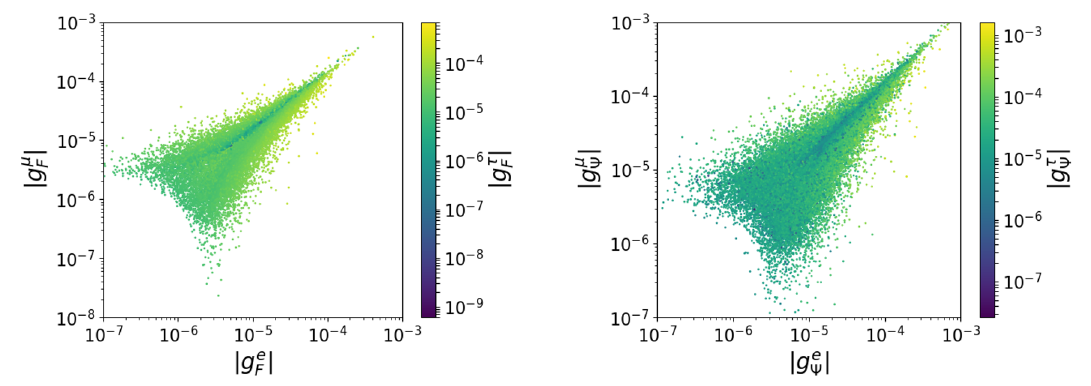
Figure 7 . Distribution of the absolute values of the coupling parameters g i obtained from the Markov Chain Monte Carlo